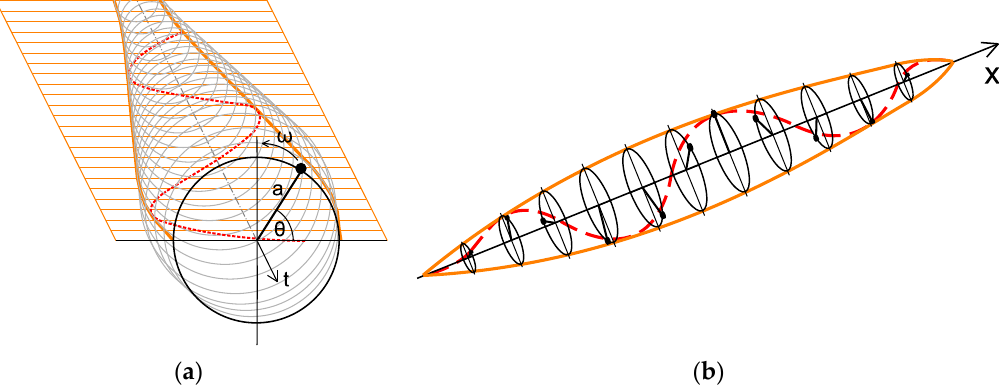
Figure 1. ( a ) The phasor concept: A phasor is uniquely defined by its amplitude A and its phase angle θ . ( b ) The phasor field is defined as having a phasor in each point in space.